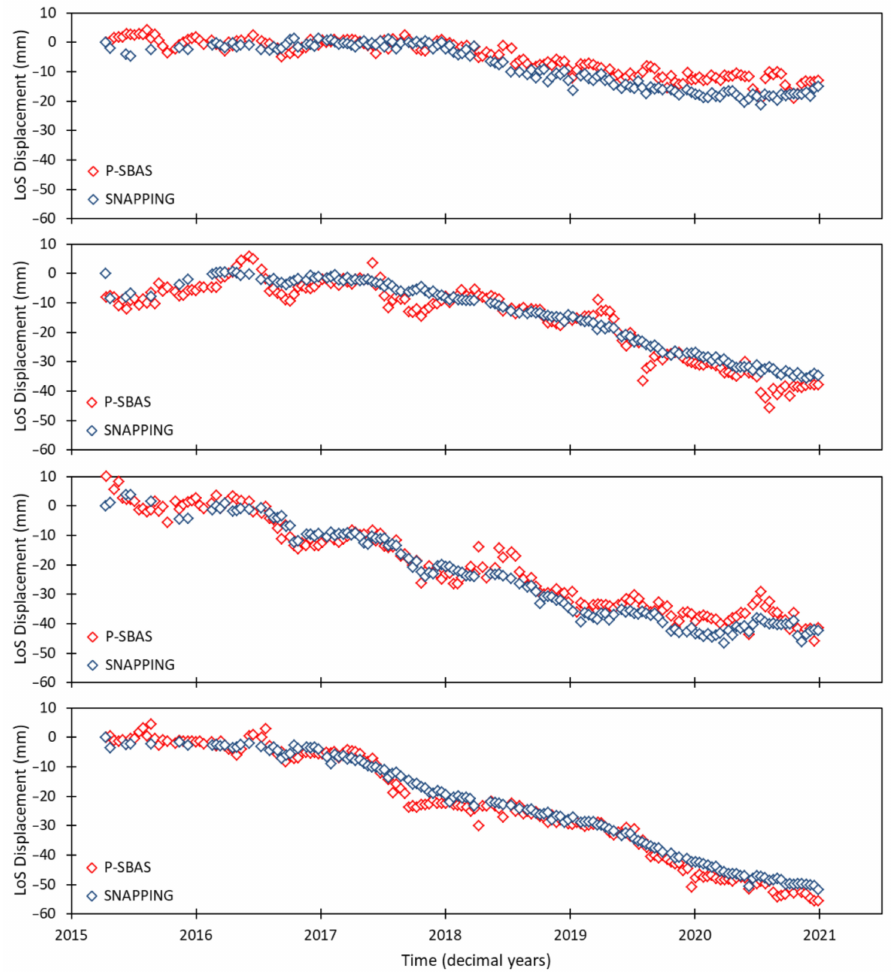
Figure 10. LoS displacement time series of randomly selected point measurements in Thessaloniki area as derived using SNAPPING and P-SBAS services on GEP. The overall consistency of indepen- dent interferometric measurements for different temporal deformation patterns can be